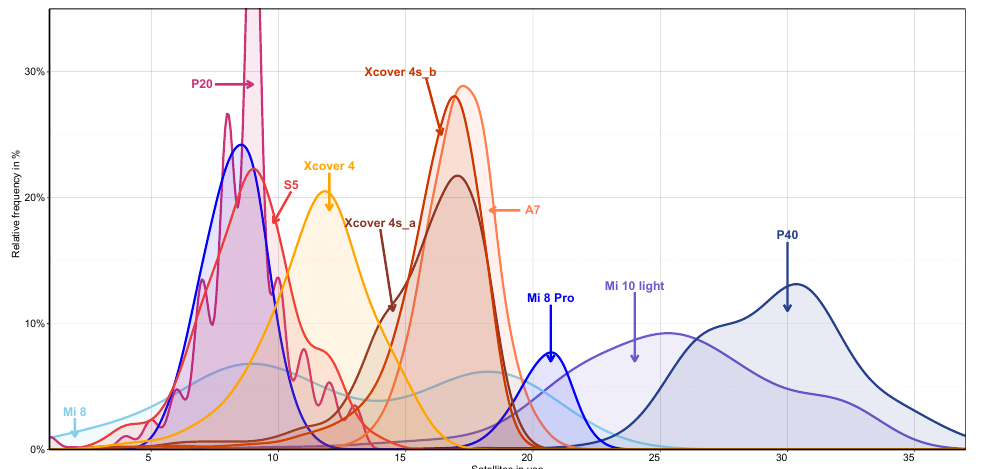
Figure 5. Relative distribution of satellites in use by the smartphones studied. Blue indicates smartphones that have multi-frequency capabilities, and red indicates smartphones that can only receive the L1/G1/E1/B1l bands.